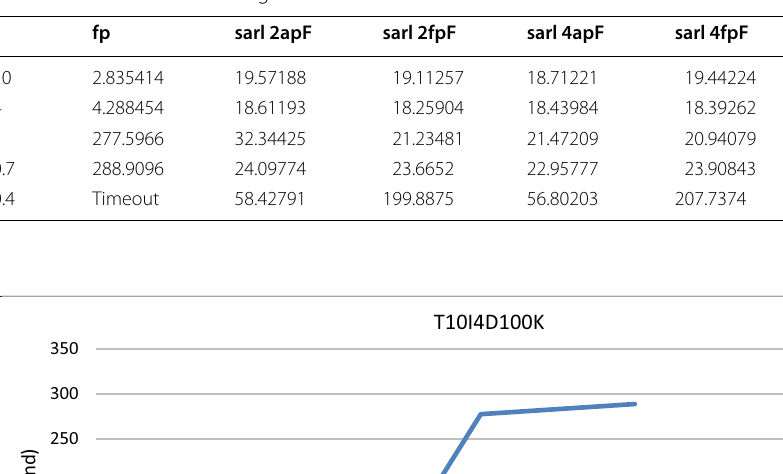
Table 15 T10I4D100K running times